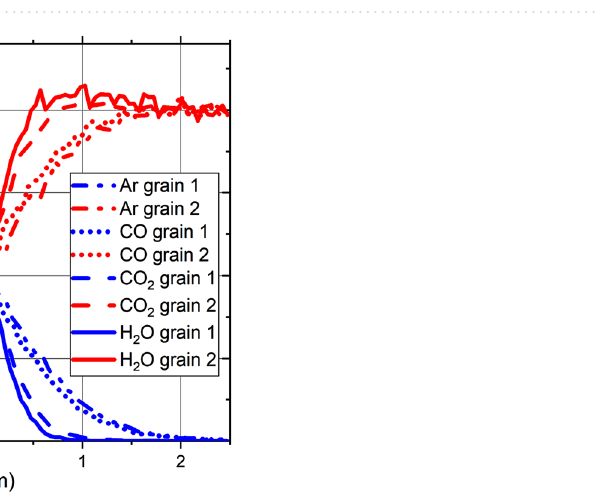
Figure 6. Temperature profile in the collision zone for NP collisions with the species indicated. Data taken at a time of 30 ps. The color scale changes for each species due to the different heating. The snapshots are at the same scale.